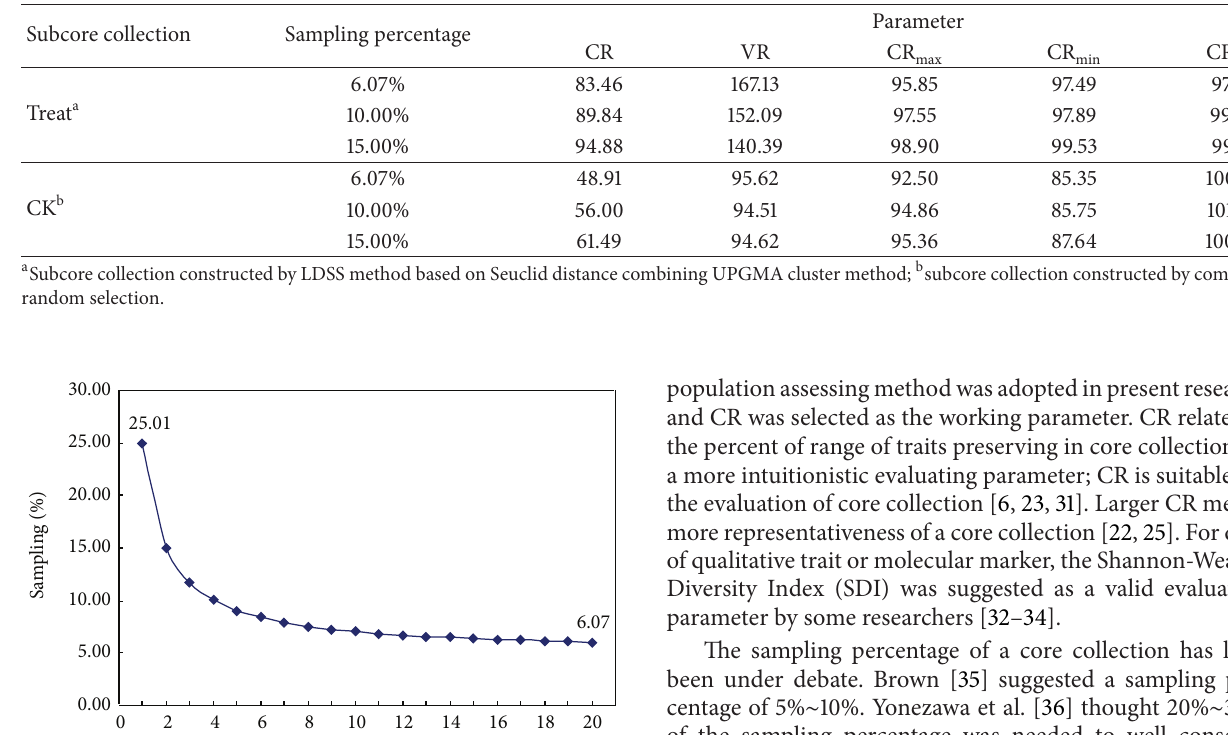
a The complexity of the formula; b the error of the fitted formula; c 𝑅 2 : the coefficient of determination; d FN: formula number.